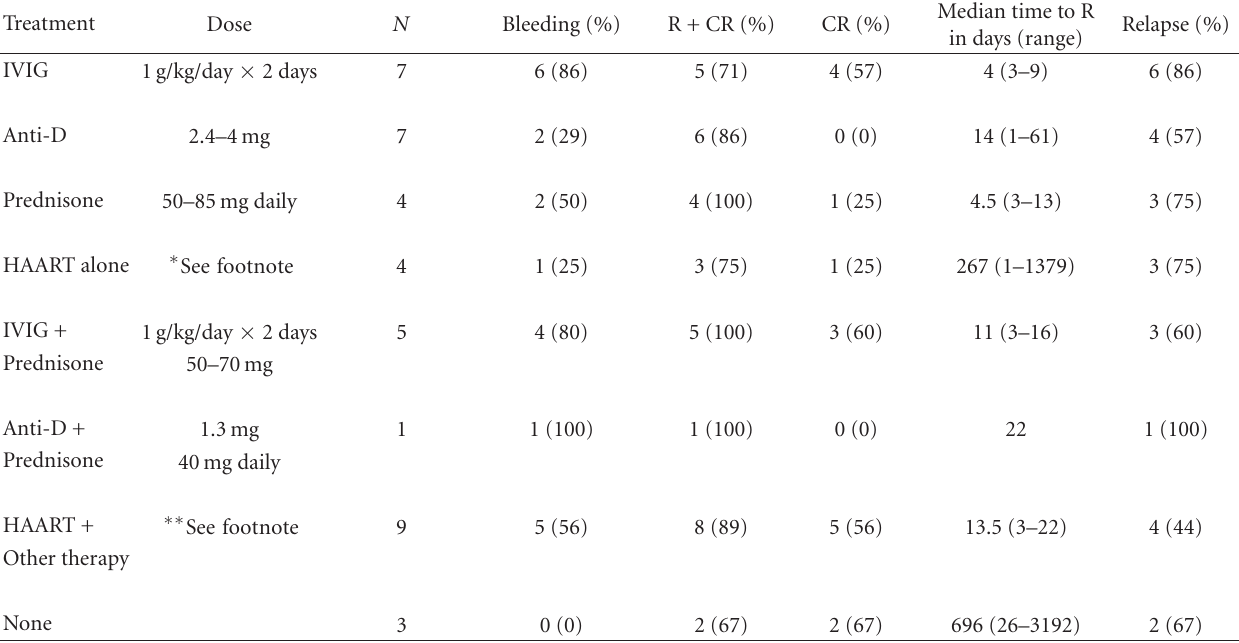
Table 2: Treatment regimens for HIV-associated ITP and responses